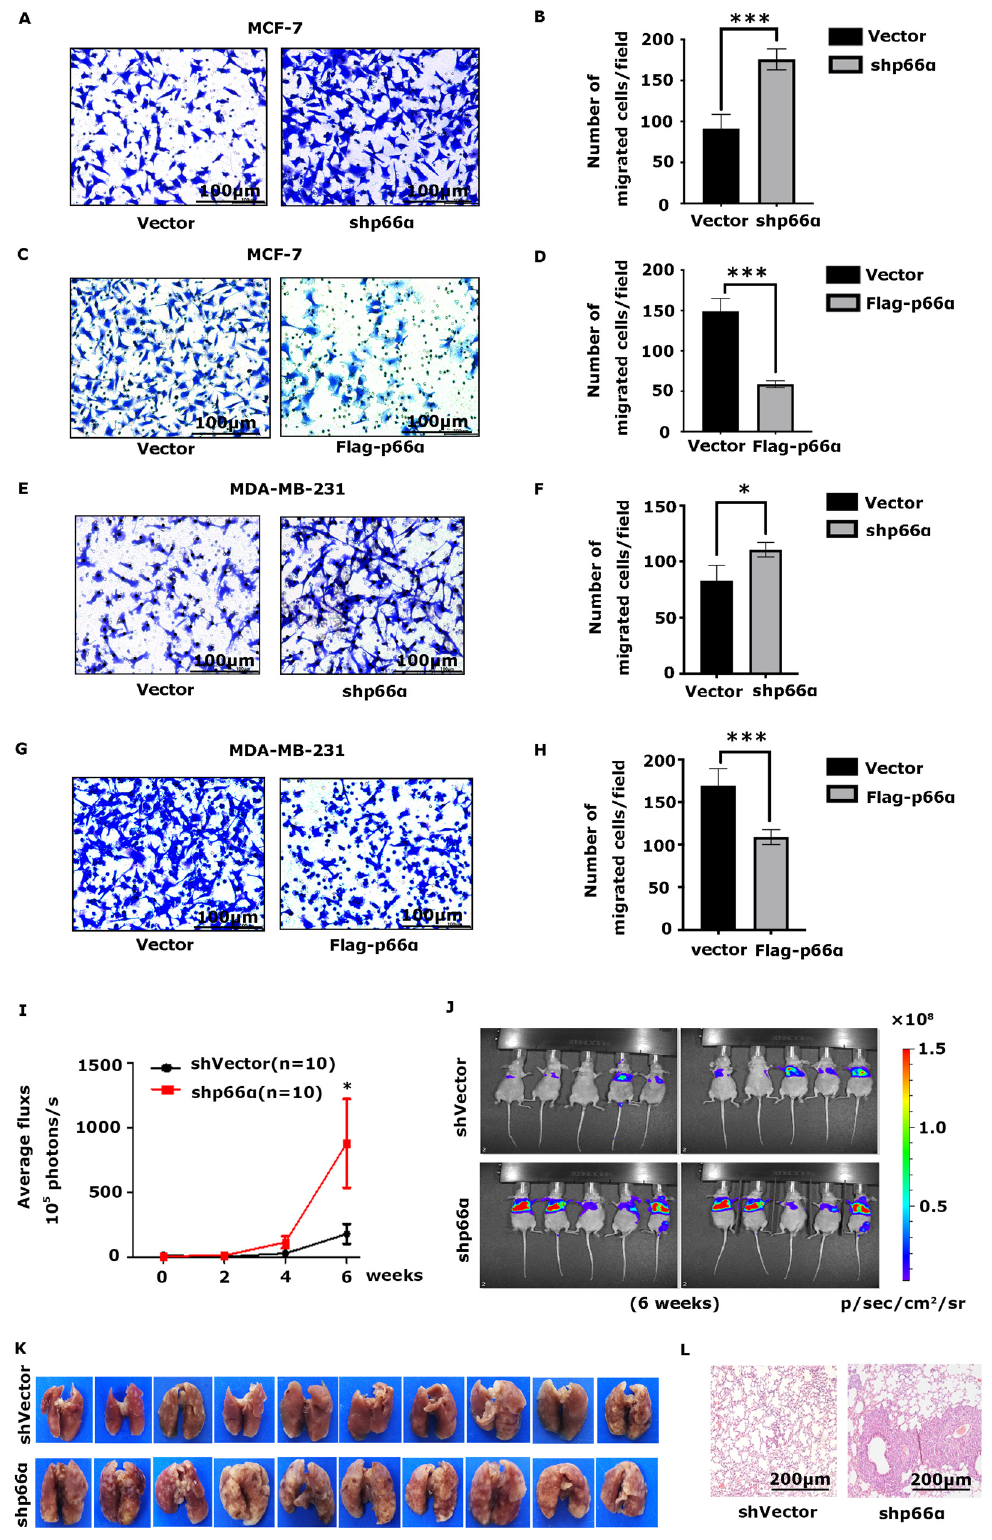
Figure 2. p66 α suppresses breast cancer cell migration and metastasis. ( A ) Transwell assays demonstrated that knockdown p66 α increased migration in MCF-7 cells (20×, scale bar: 100 μ m). ( B ) Quantification analyses of cell migration abilities of p66 α knockdown or vector MCF-7 cells. *** p < 0.001. ( C ) Transwell assays showed that an increase in p66 α levels reduced migration in MCF-7 cells (20×, scale bar: 100 μ m). ( D ) Quantification analyses of cell migration abilities of MCF-7 cells overexpressing p66 α or vector. *** p < 0.001. ( E ) Depletion of p66 α increased cell migration in MDA-MB-231 cells. (20×, scale bar: 100 μ m). ( F ) Quantification analyses of cell migration abilities of p66 α knockdown MDA-MB-231 cells. * p < 0.05.